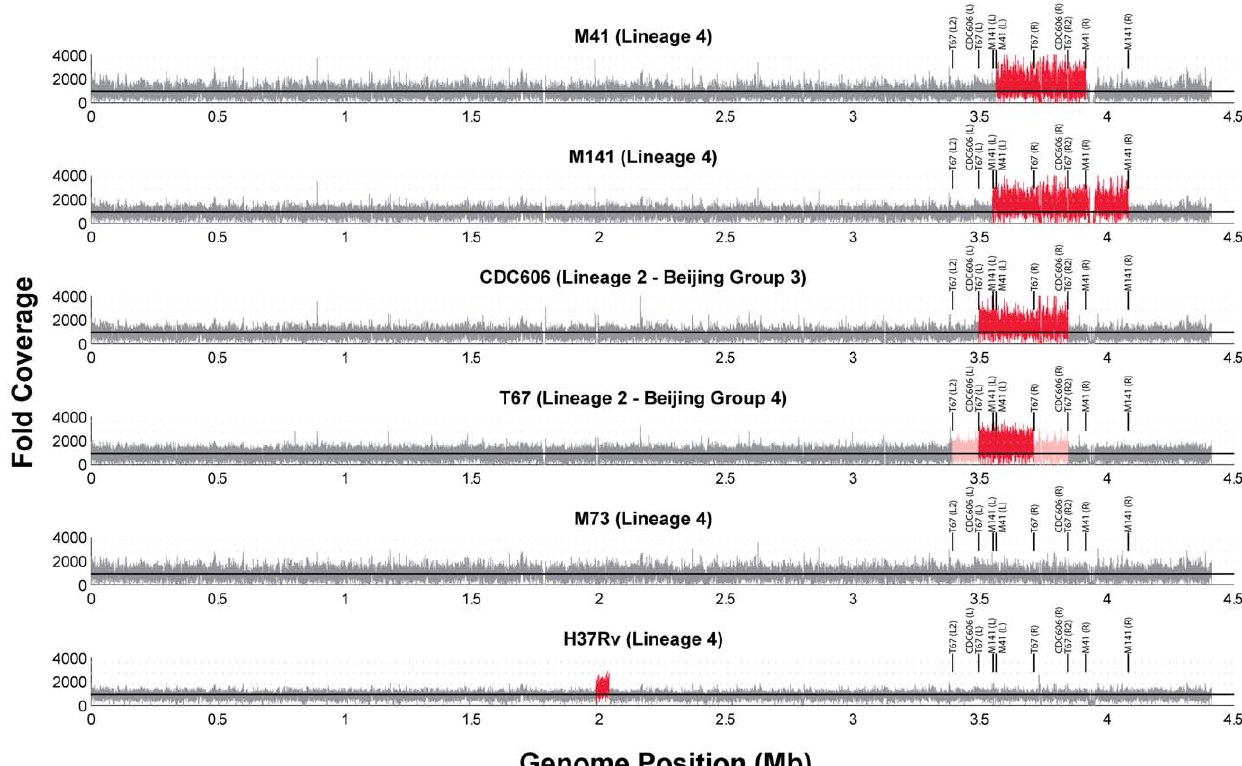
Figure 2. Coverage of sequenced strains relative to H37Rv. Each plot shows the fold coverage for the alignment of each strain to H37Rv. The mean coverage for each strain is denoted by the solid horizontal line, while multiples of the mean are denoted by the horizontal grey lines. For most of the genome the coverage varies around the mean coverage (grey). Duplicated genomic segments are apparent as regions varying around twice the mean coverage (red). T67 also contains regions with coverage between 1 6 and 2 6 the mean (pink). The boundaries of each duplicated region are shown as vertical lines in each plot.